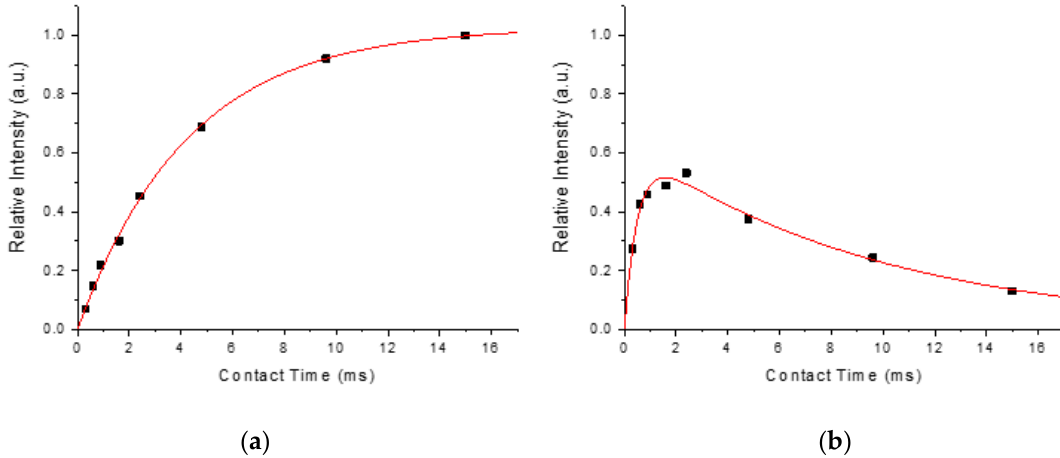
Figure 4. Modulation of the signals of the 31 P{ 1 H} LG-CP HETCOR spectra at variable contact times for the R 21 sample. The profiles were fitted on the basis of Equation (1), from which the parameters of M 0 , τ CP , and T 1 ρ were extracted. ( a ) HAp; ( b ) dentin-amorphous calcium phosphate (ACP).